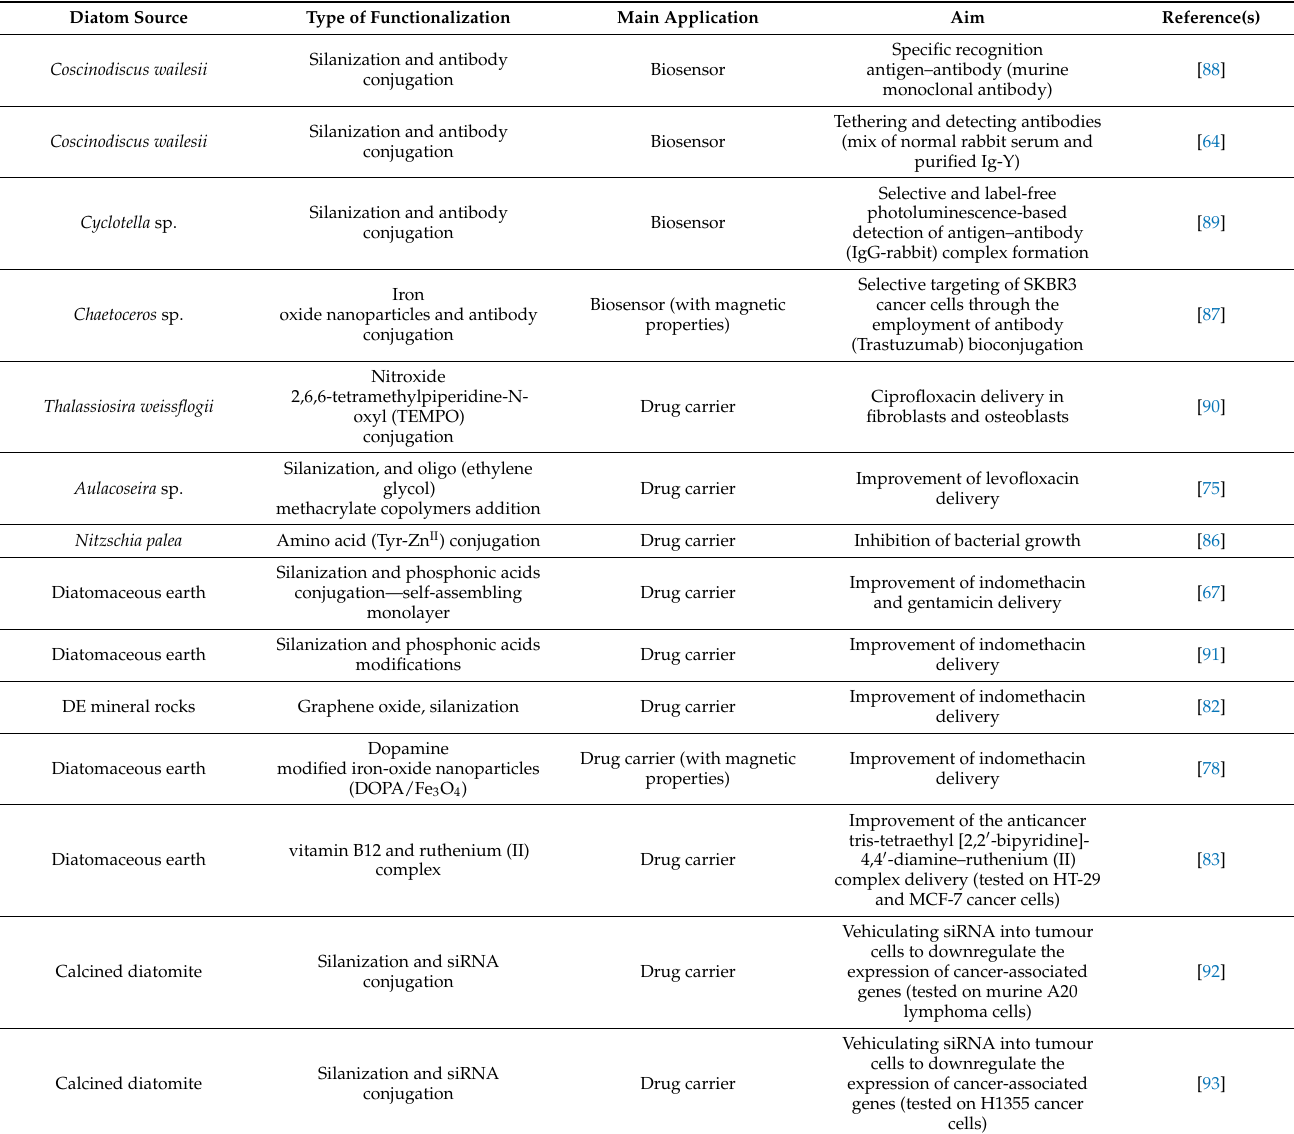
Table 2. Sources, type of functionalization and biomedical applications of diatom-derived